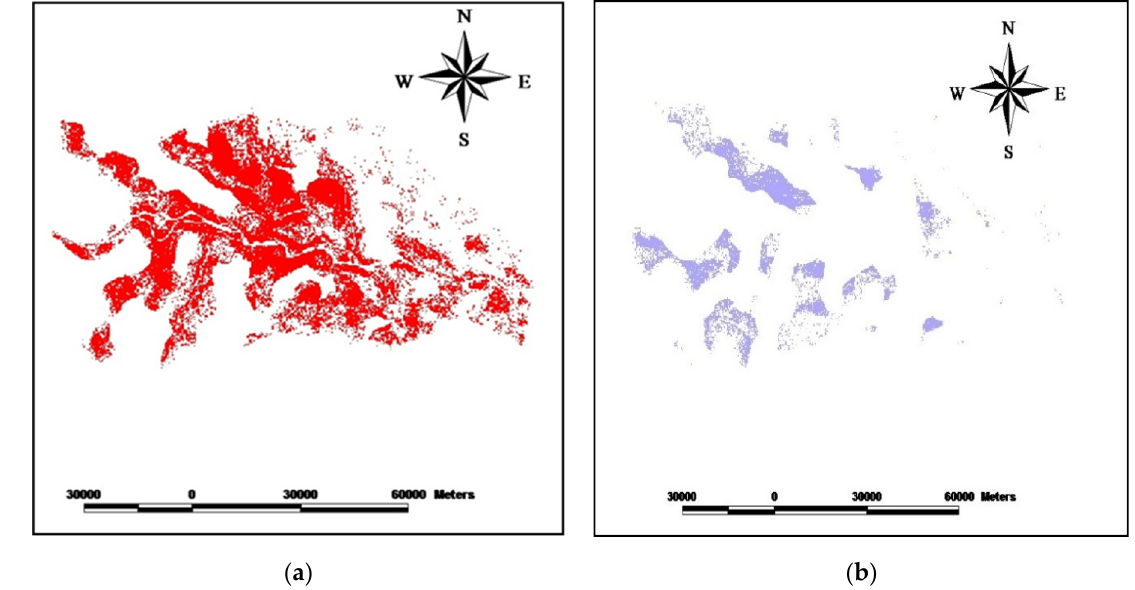
Figure 8. Flood susceptible zone with respect to distance from river; ( a ) susceptible zone < 500 m, ( b ) susceptible zone > 500 m.